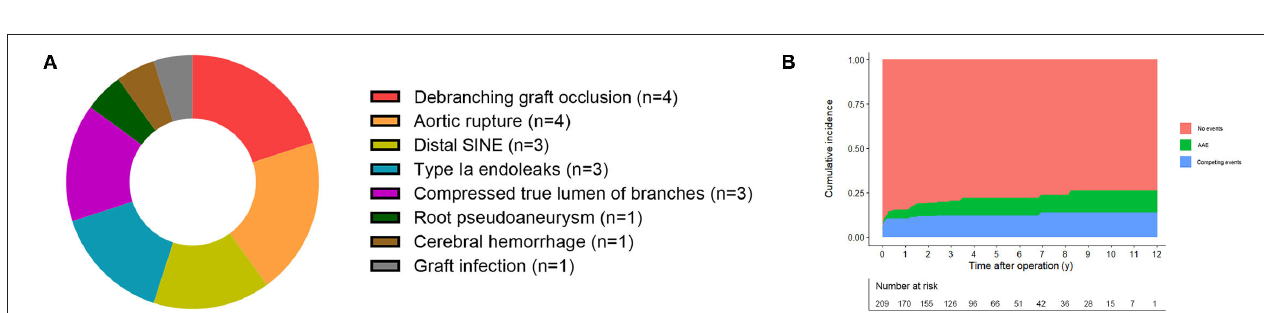
FIGURE 4 | Adverse aortic events analysis. (A) The proportion of AAEs in the follow-up. (B) Cumulative incidence of AAEs in the presence of death as competing risk. AAEs, adverse aortic events.